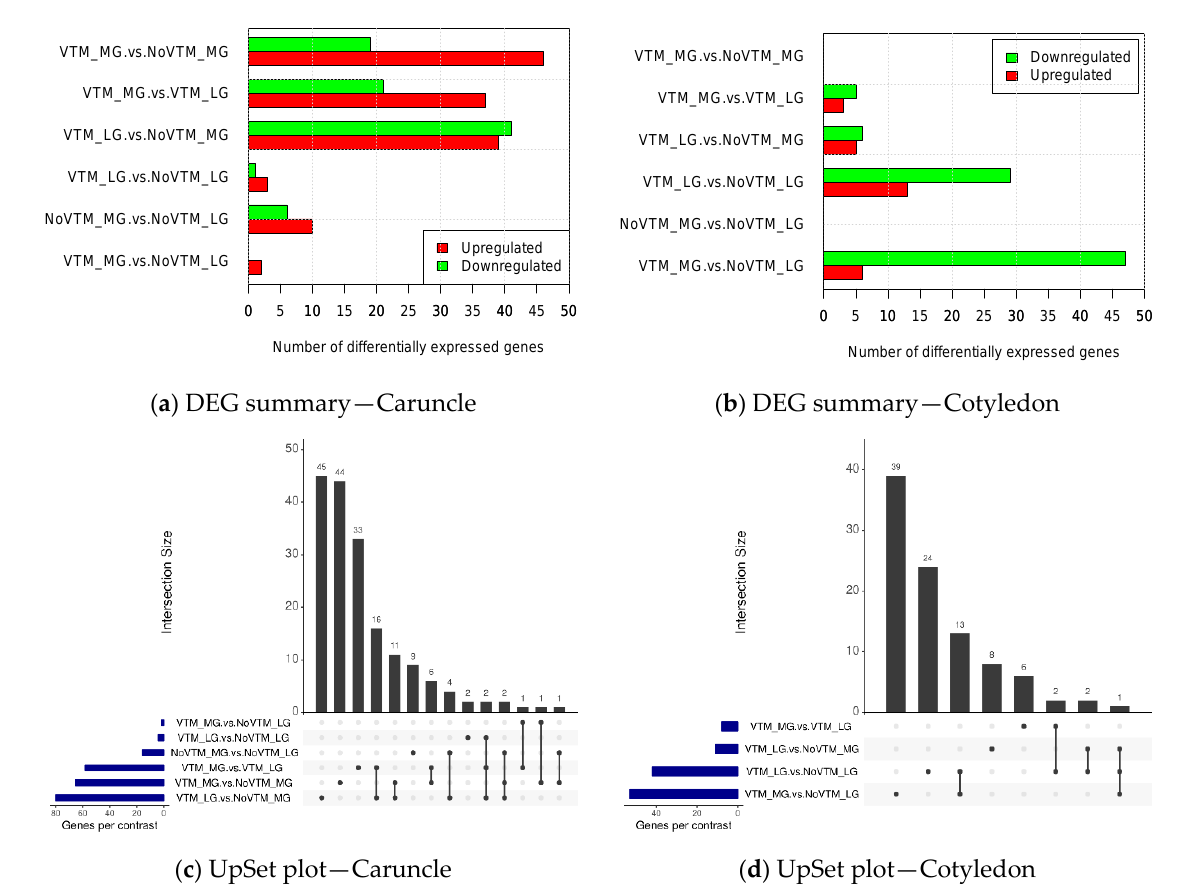
Figure 2. Differential gene expression summary of bovine placental tissues—caruncle (maternal placenta) ( a ) and cotyledon (fetal placenta) ( b ) ( padj ≤ 0.1). The UpSet plot represents the intersection between the sets of differentially expressed genes (DEGs) from different contrasts of caruncle ( c ) and cotyledon ( d ). Each vertical bar shows the number of genes in the intersection. The dot plot reports the set participation in the intersection, and the horizontal bar graph reports the set sizes (total of DEGs). The treatments were arranged as follows: NoVTM_LG—no vitamin and mineral supplementation and low gain; VTM_LG—vitamin and mineral supplementation and low gain; NoVTM_MG—no vitamin and mineral supplementation and moderate gain; and VTM_MG—vitamin and mineral supplementation and moderate gain.